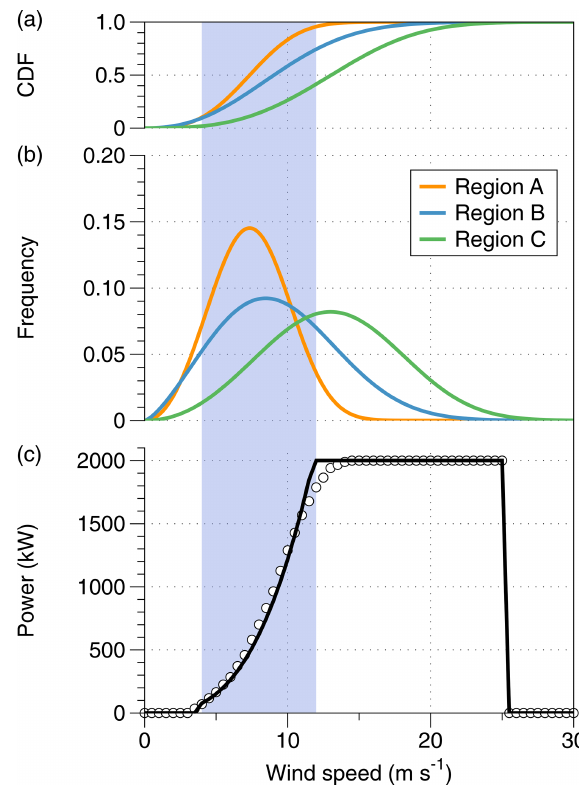
Figure 2. Wind forcing and turbine power curve used for the eval- uation of KEBA. Panels (a, b) show the frequency distribution of wind speeds for the three regions (A: Iowa, US (orange); B: North Sea (blue); C: Strait of Magellan (green)) considered here including their cumulative distribution function (CDF) at the top. Panel (c) shows the power curve used here for the Vestas V-80 2MW wind turbines with a power coefficient of η = 0 . 44, with the circles representing the actual power curve of the turbine (obtained from http://www.windpower.net, last access: 20 March 2020). Both form the inputs of the KEBA evaluation and are based on the data provided in Volker et al. (2017). The blue shaded region reflects wind speeds at which the turbine operates above its cut-in but be- low its rated